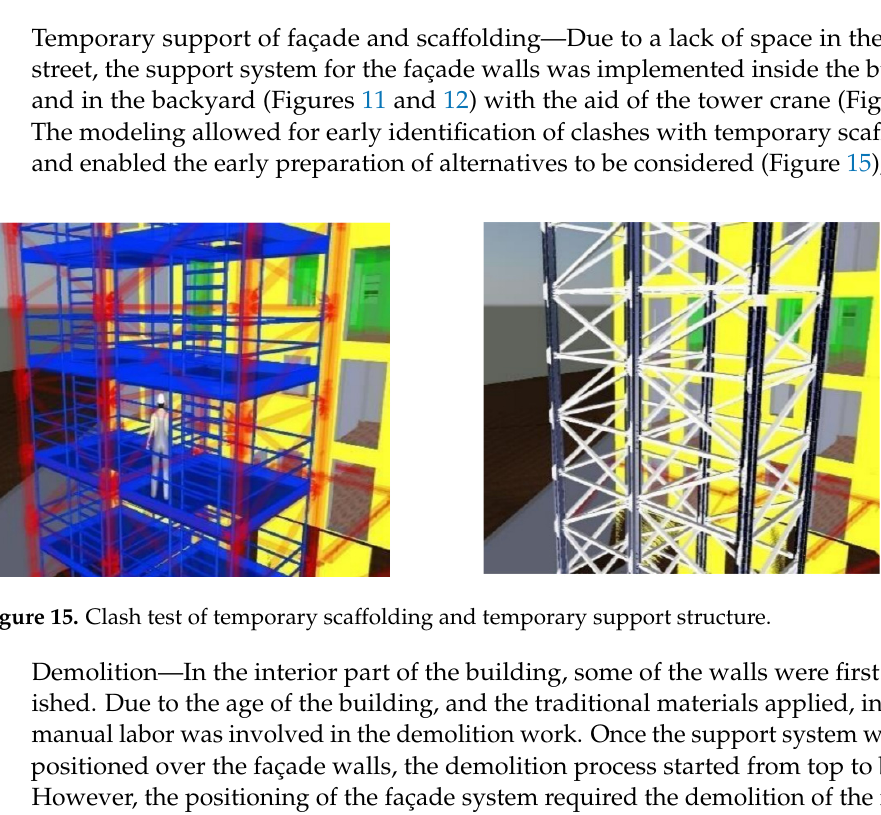
Figure 14. Insertion of the tower crane and guardrails for fall protection in temporary shafts.